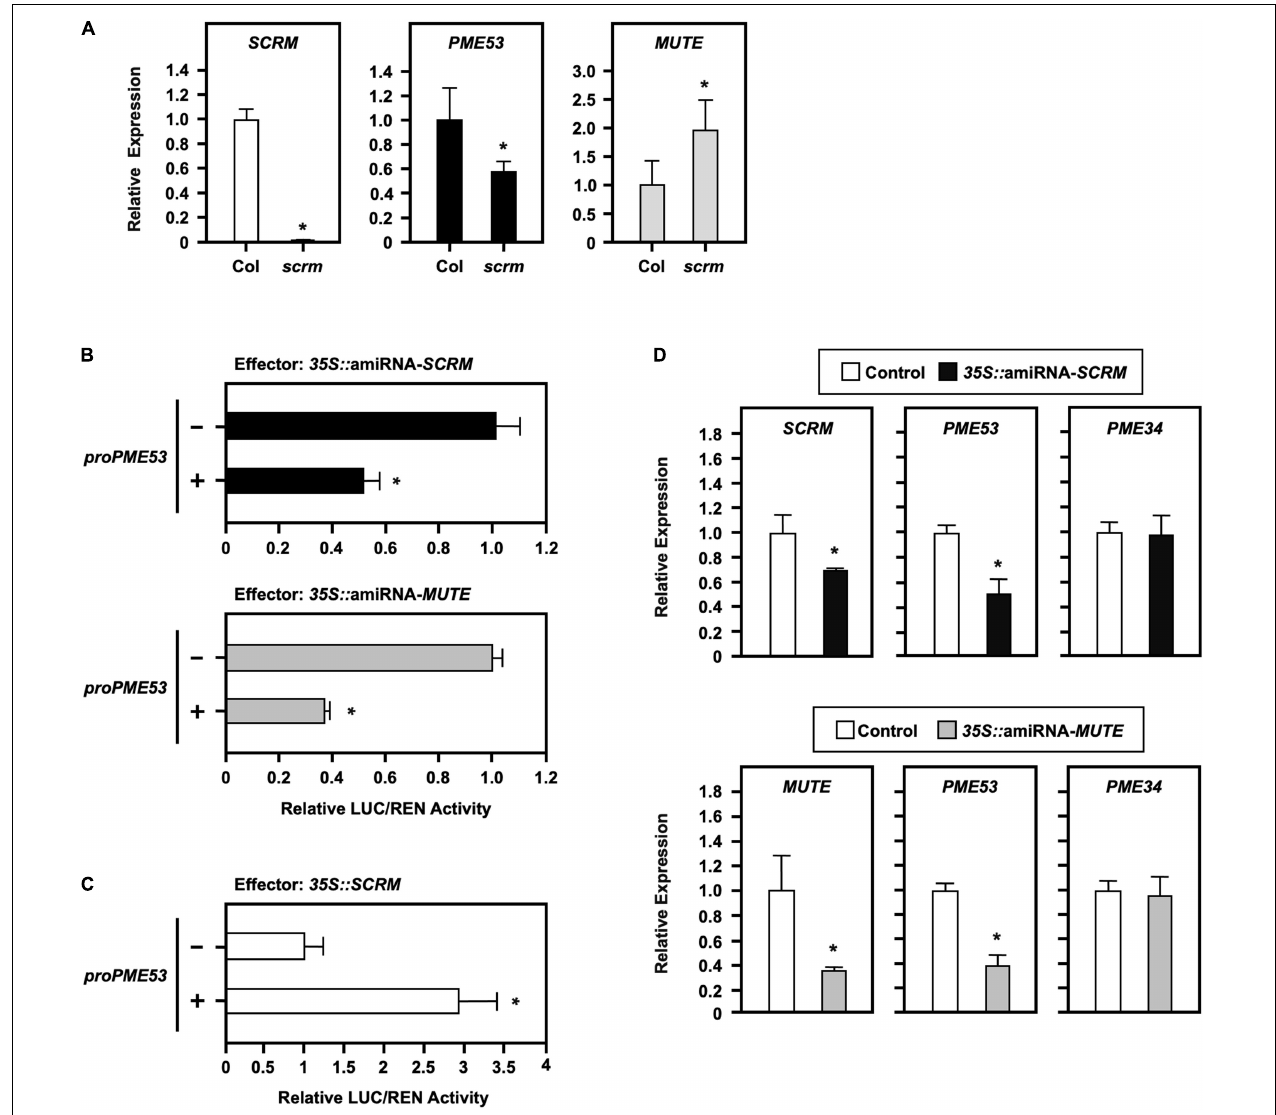
FIGURE 6 | Effect of the stomatal-positive master regulator SCRM on PME53 expression. (A) The expression levels of SCRM , PME53 , and MUTE in 7-day-old seedlings of Col and scrm (the null-mutant line) were analyzed by q-PCR. The fold change expression was normalized relative to the level of Col. (B,C) The 35S:Effector of artificial miRNA mediated the suppression of SCRM and MUTE expression (amiRNA- SCRM and amiRNA- MUTE ) and 35S:SCRM , were used for the trans -activation analysis of PME53- promoter :LUC reporter in Arabidopsis protoplasts, respectively. The fold change expression was normalized relative to the activity of LUC/REN using the dual-luciferase system. *Significant at P < 0.05 compared with the mock control (-). (D) The expression levels of SCRM , MUTE , PME53 , and PME34 were analyzed by q-PCR. PME34 was used as a negative reference control. Data are mean ± SE of three biological